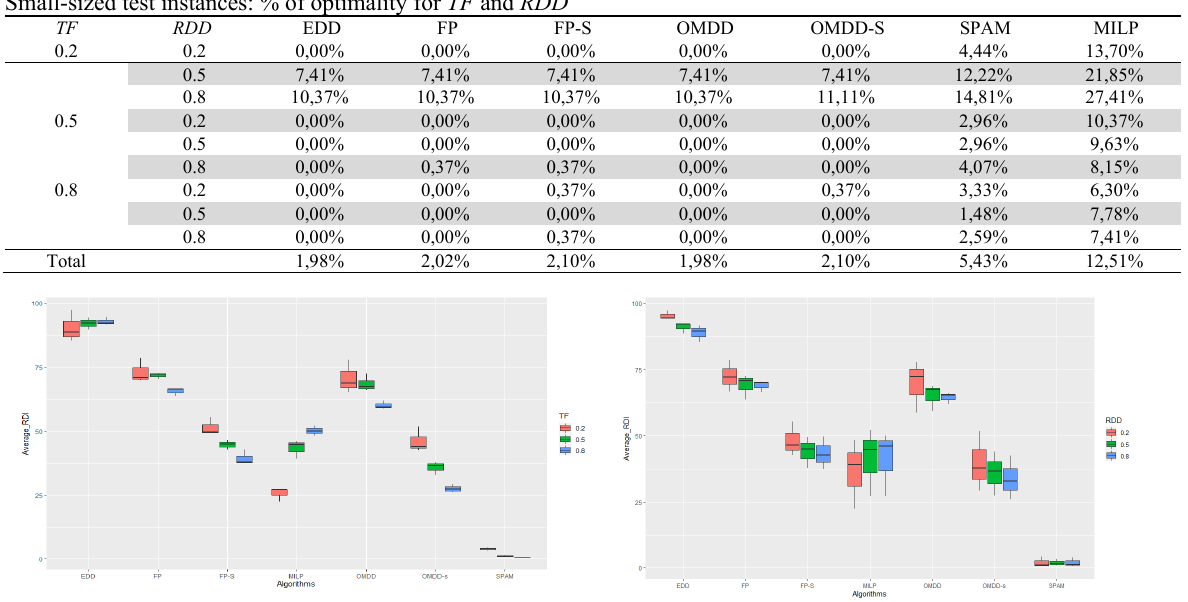
Fig. 5. Small-sized test instances: boxplot for average 𝑅𝐷𝐼 values depending on 𝑇𝐹